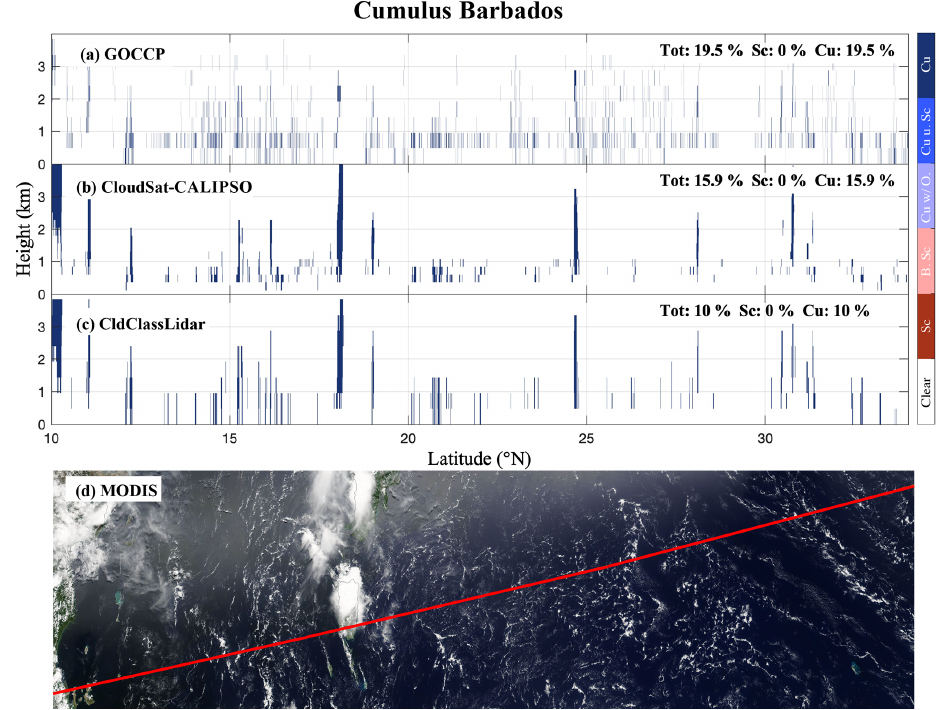
Figure 10. Same as Fig. 8 but for another cumulus case overpassing Barbados ( ∼ 10 to 35 ◦ N, 9 July 2008 17:34:08 daytime).